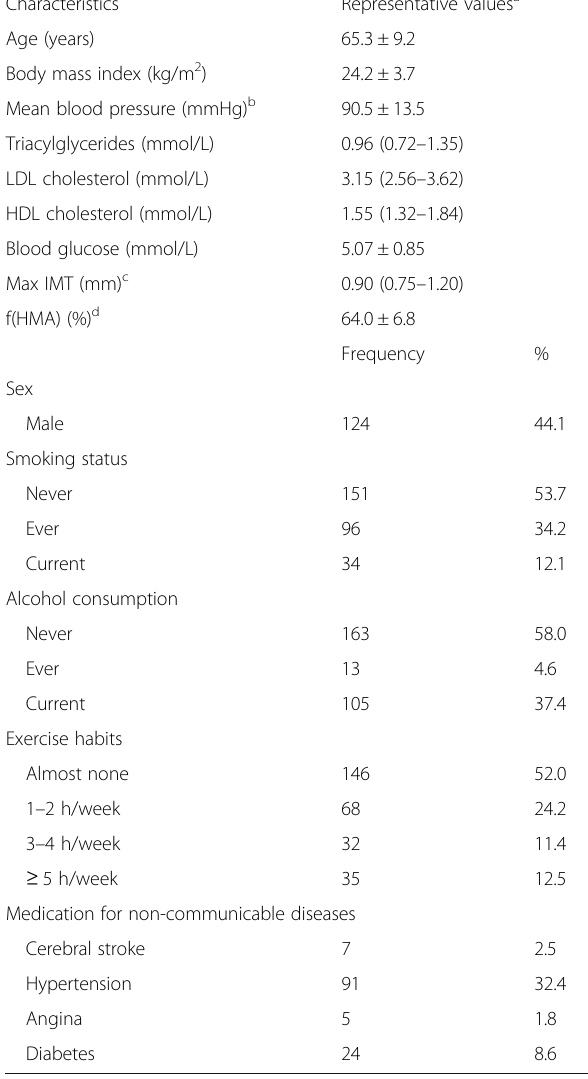
Table 1 Main characteristics of the subjects ( n =